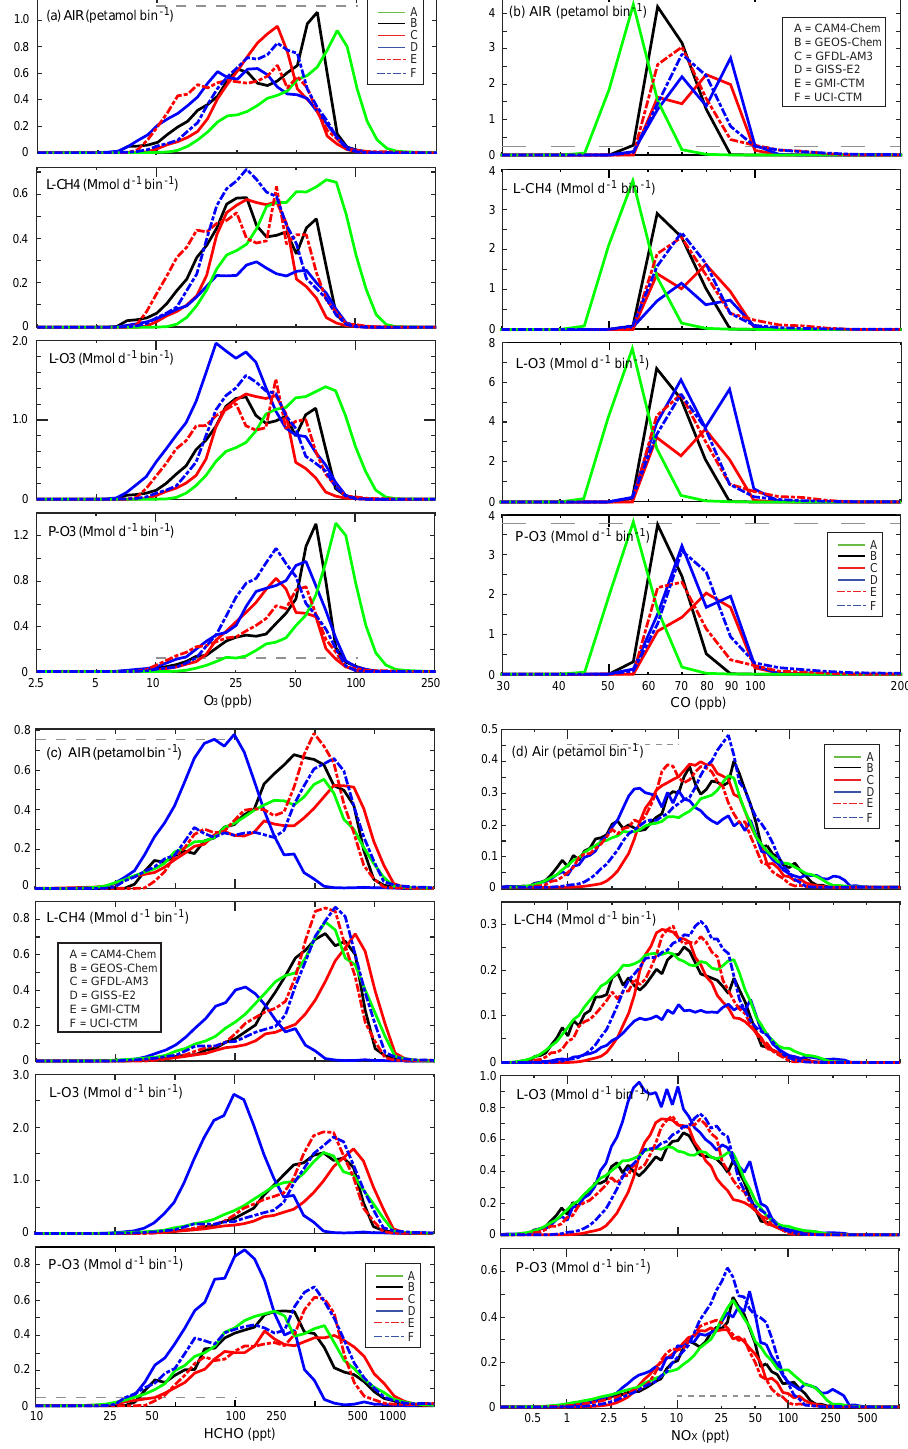
Figure 5. Six modeled 1-D probability distributions for O 3 , CO, NO x , and HCHO, where the air parcels have been weighted by air mass (row 1), L-CH4 (row 2), L-O3 (row 3), and P-O3 (row 4). The domain being sampled in the models is the tropical Pacific: 20 ◦ S–20 ◦ N, 150–210 ◦ E, 0.5–12km. Units for the air weighting are petamoles per bin where the bins are set at 20 per decade (sizes marked by dashed lines in upper or lower panels) and Mmoles per bin per day for the reactivity-weighted plots (rows